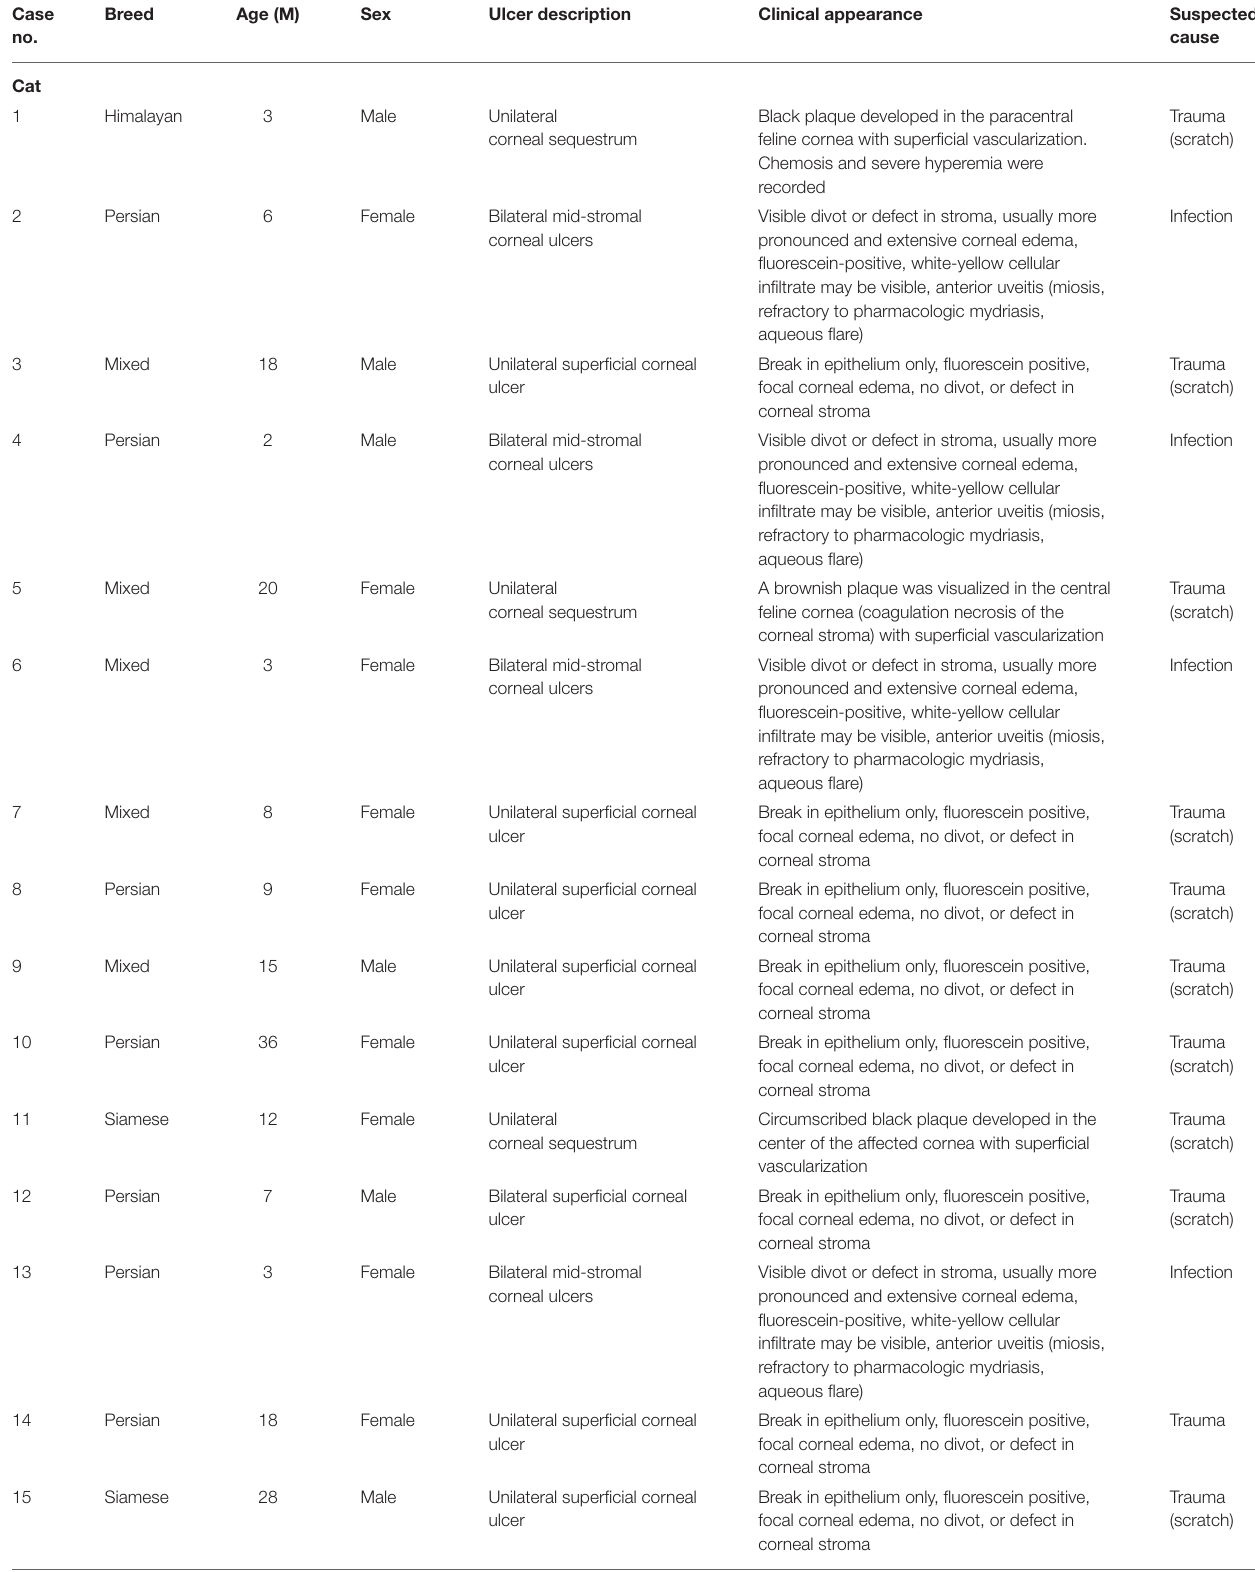
TABLE 2 | Patient signalments and description. Case